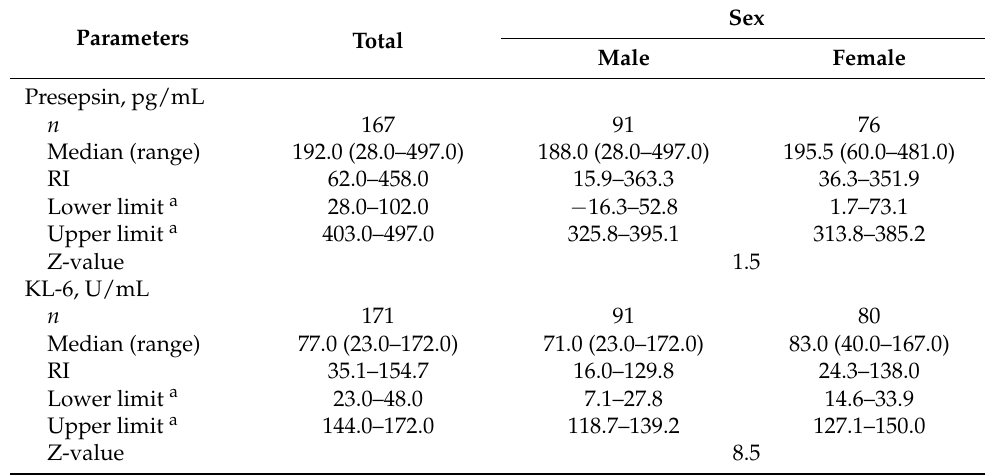
Table 4. Reference intervals of the healthy group for presepsin, KL-6, and SP-A.